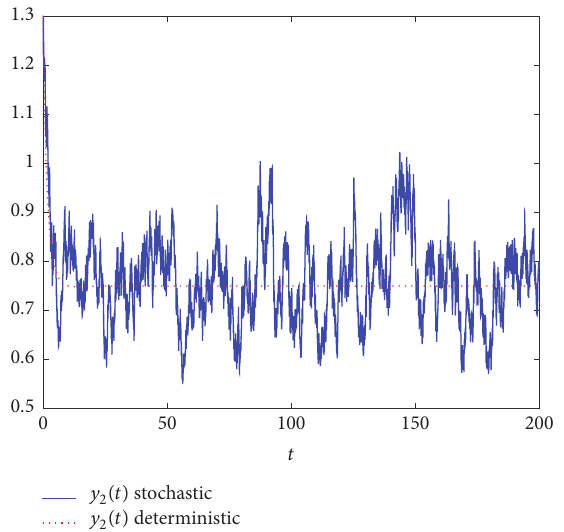
Figure 2: Solution of model (62) for 𝛾 1 (𝜃) = (1.5, 1.3, 1) . Blue: 𝜎 𝑖 = = 0 (𝑖 = 1, 2, 3, 4, 5) . 0.1 (𝑖 = 1, 2, 3, 4, 5) . Red: 𝜎 𝑖